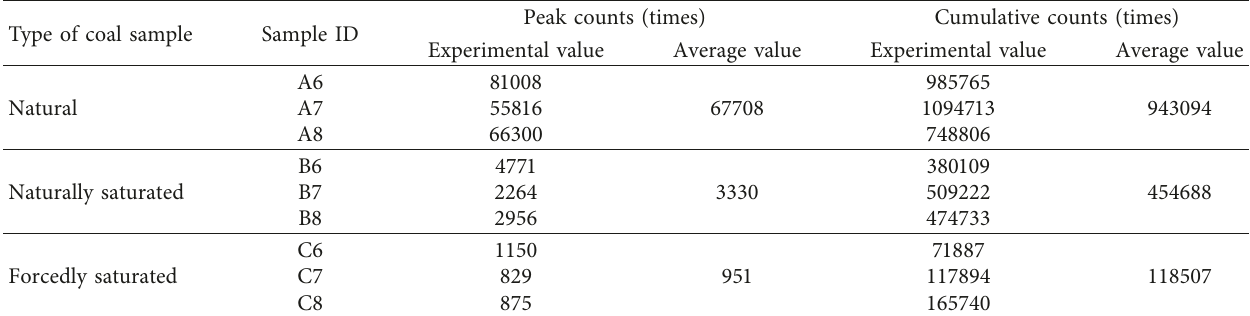
Figure 7: The relationships between stress and strain of natural, naturally saturated, and forcedly saturated coal samples. Table 5: Experimental results of AE